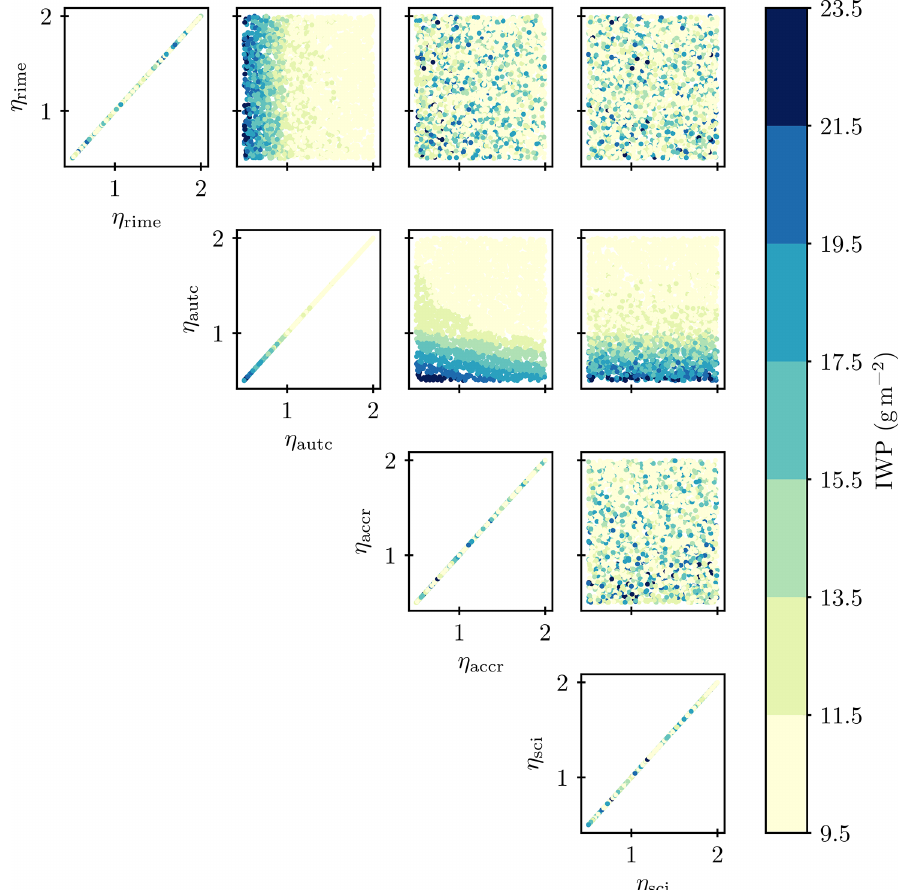
Figure 7. Two-dimensional projections of the IWP values sampled from the four-dimensional parameter space of the emulated PPE. Each perturbed process is a dimension, and the color bar denotes the global annual mean ice water path for each input parameter